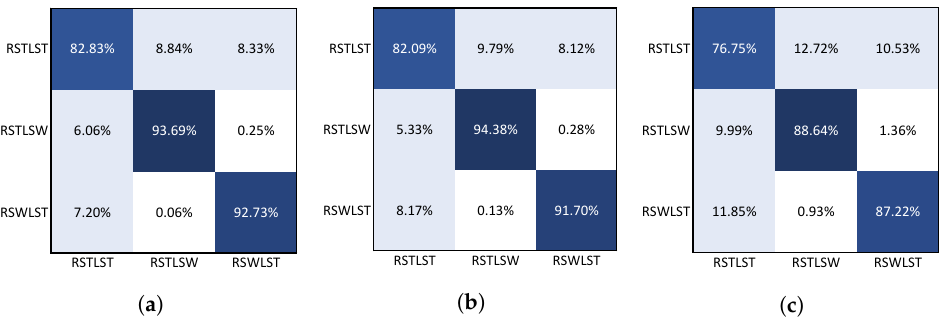
Figure 7. Confusion matrix of models trained with textile pressure sensors data from participant